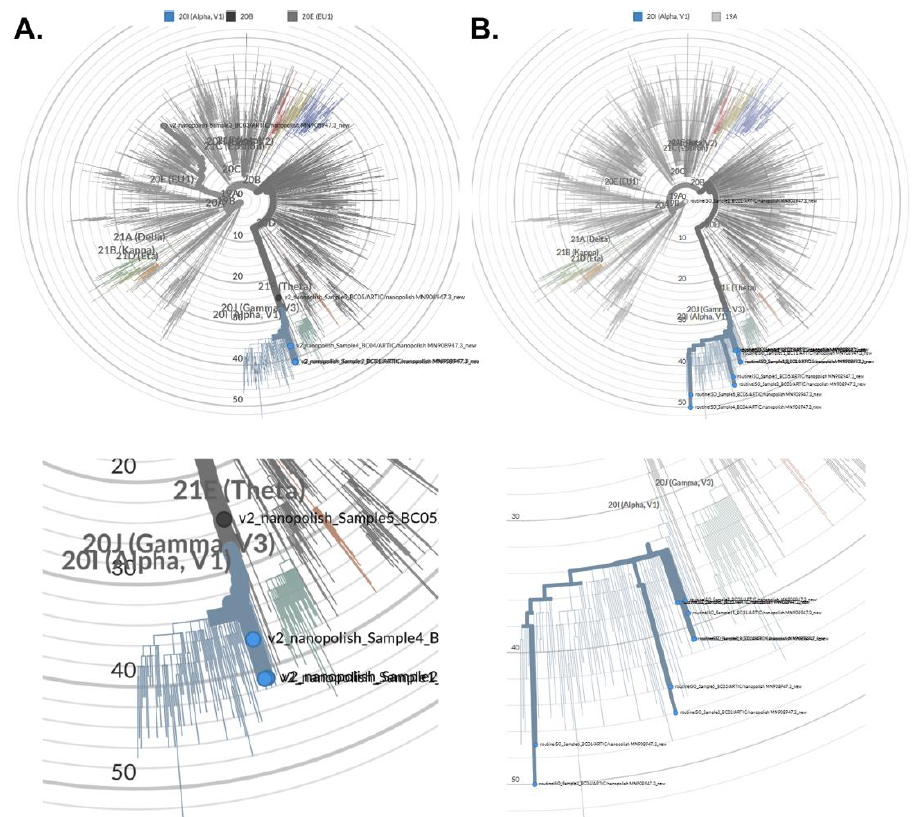
Figure 4. Comparison on the evolutionary distance calculation, when data from the same specimen was processed by 2 different bioinformatics pipelines. Phylogenetic tree visualization was done using the Nextstrain open-source platform for pathogen genome data analyses [14]. We used serial dilutions of identical specimens ( A ), or a selection of samples from different individuals from clinical routine ( B ) for phylogenetic analyses. Below the trees, a magnification of clade 20I is shown, wherein most specimens are grouped ( A , B ).